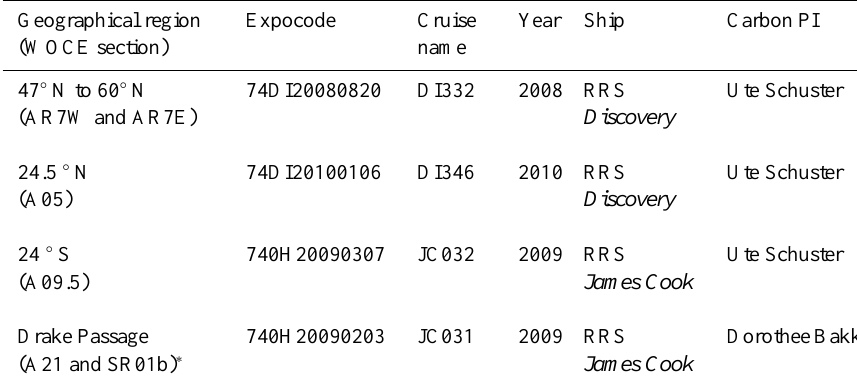
Table 2. Geographic region (WOCE section), Expocode, cruise name, year, ship, and carbon PI for each cruise.